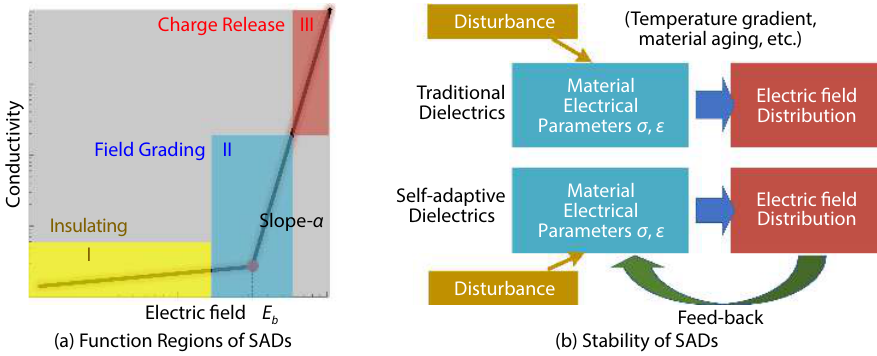
Fig. 2 Application mechanism of self-adaptive dielectrics. ( a ) Typical nonlinear J ( E ) characteristics of SADs and their function regions. ( b ) Schematic diagram of the field grading mechanism of